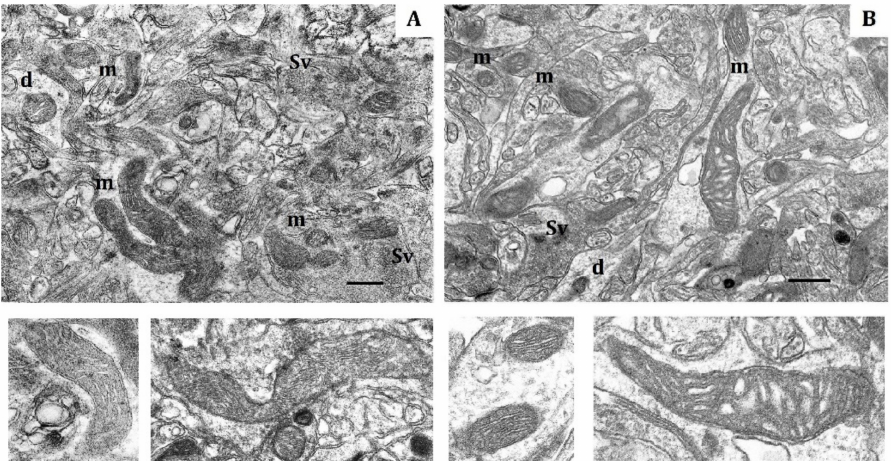
Figure 5. Electron micrograph showing the effect of long-term hypobaric hypoxia (HBH-10% O 2 ) on mitochondria of the rat cerebral cortex. ( A ) rats with low resistance to hypoxia; ( B ) rats with high-resistance to hypoxia. Scale bar: 0.5 µ m. For other designations, see legends to Figure 1. 2.4. Effects a Course of the “Severe” Hypobaric Hypoxia (HBH, 8% O 2 ; O 2 Concentration in